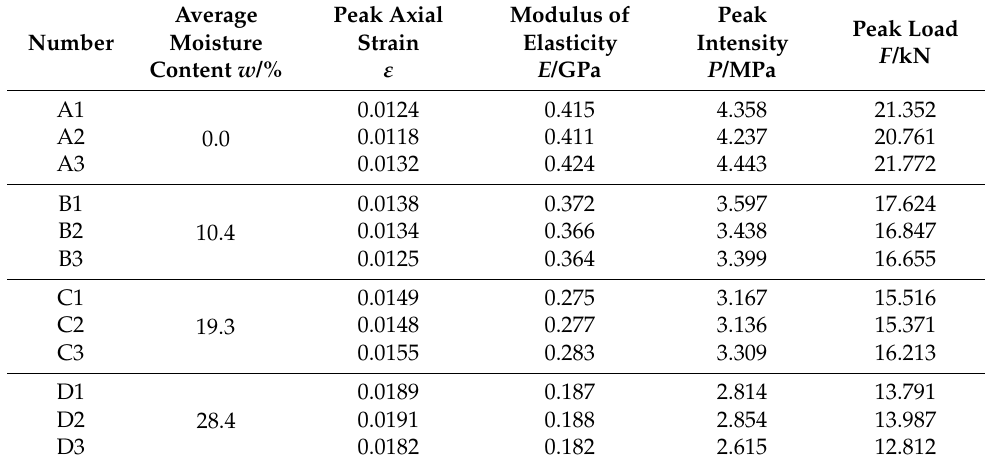
Table 1. Basic parameters of specimens derived from uniaxial compressive test.